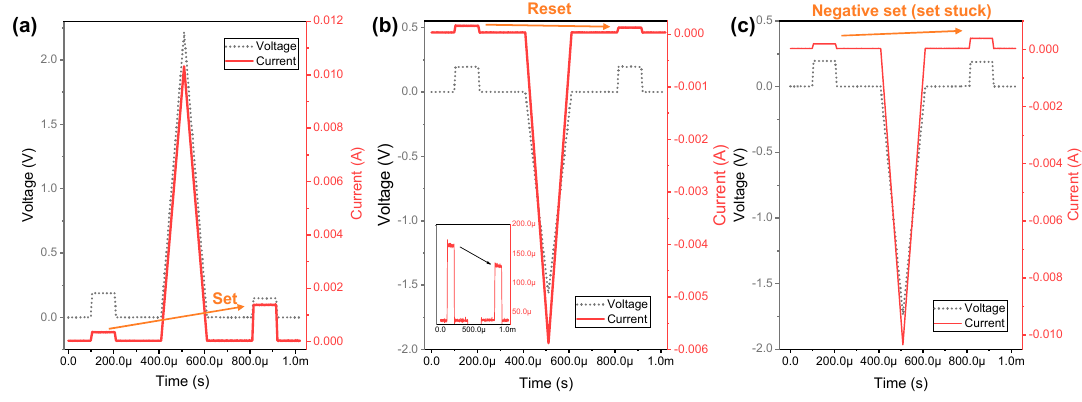
Figure 4. ( a ) Set, ( b ) reset, and ( c ) set stuck by pulse operation mode.